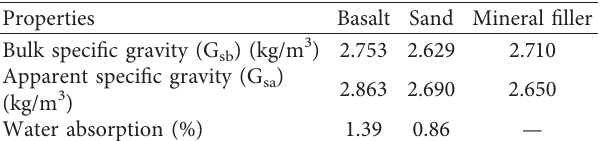
Table 3: Volumetric properties of Mix ref, Mix 1, and Mix 2.